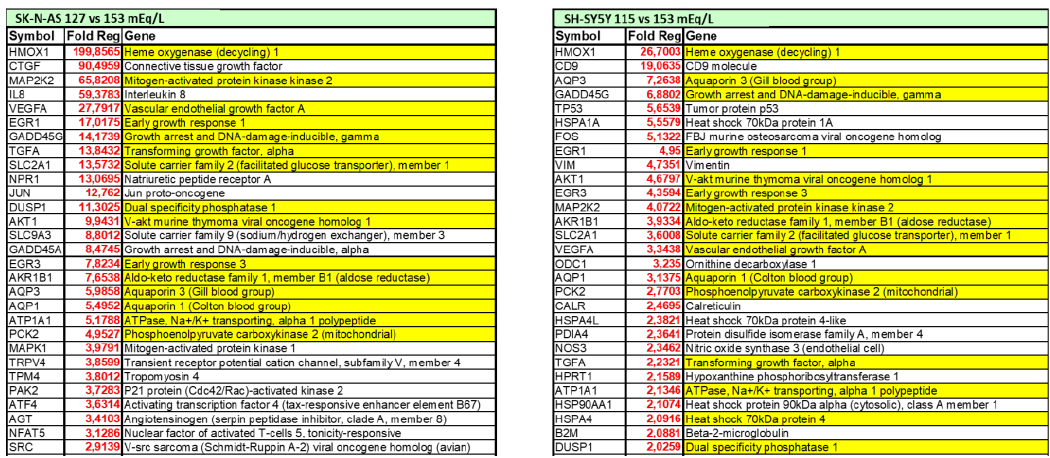
Figure 2. List of differentially expressed genes in two in vitro neuronal models (SH-SY5Y and SKN-AS cell lines), maintained at reduced (115 mmol/L and 127 mmol/L, respectively) or normal (153 mmol/L) [Na + ], as assessed by microarray analysis. Positive fold-regulations are reported in red, negative fold-regulations are in blue. Yellow marked genes are commonly regulated in both cell lines.